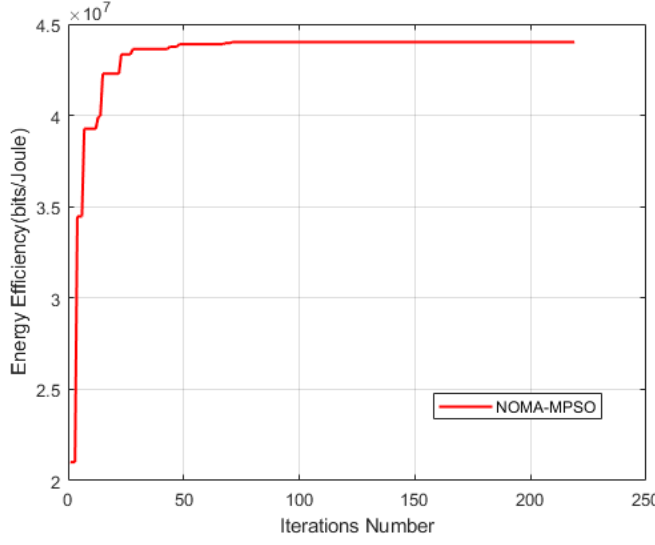
Figure 3. System energy efficiency versus the number of